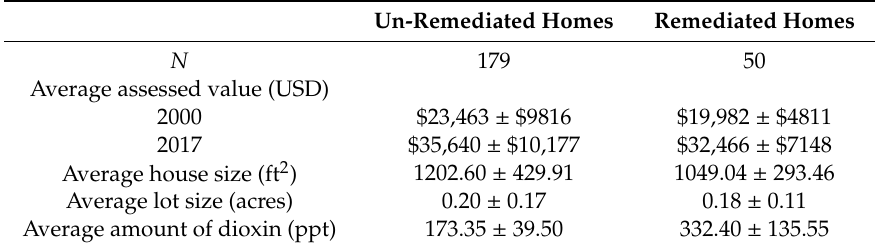
Table 1. Descriptive statistics for sampled homes.